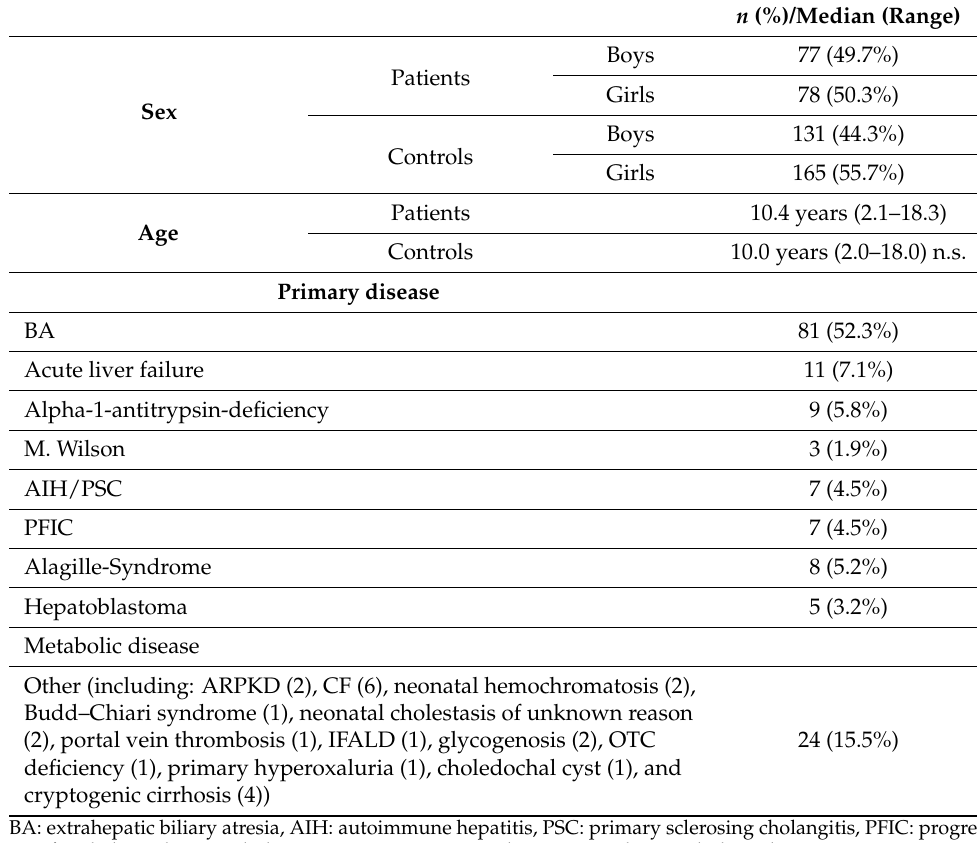
Table 1. Demographic data of the study